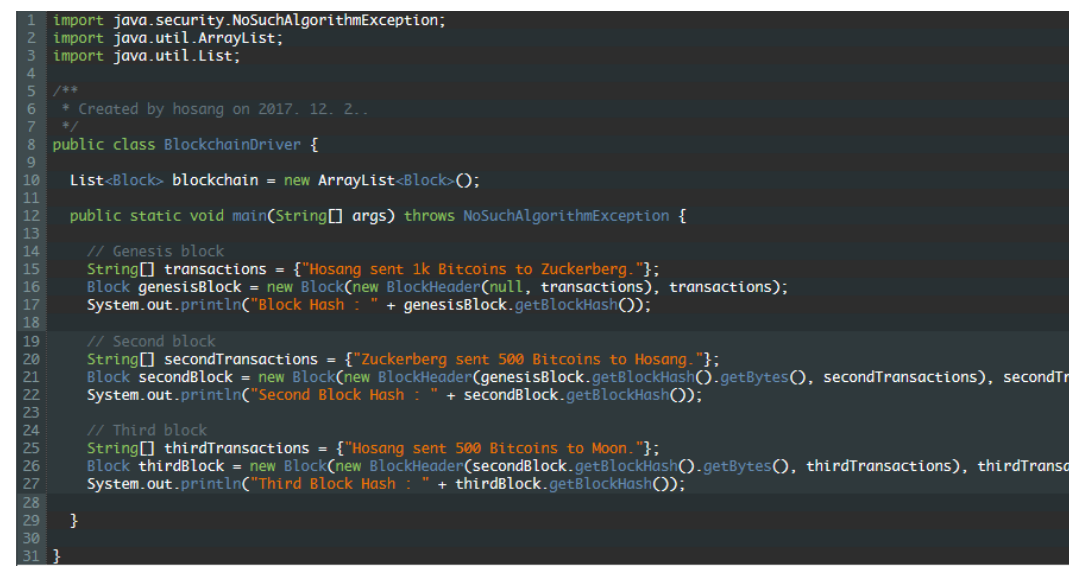
Figure 15. Generation and connection of second and third block using hash value.